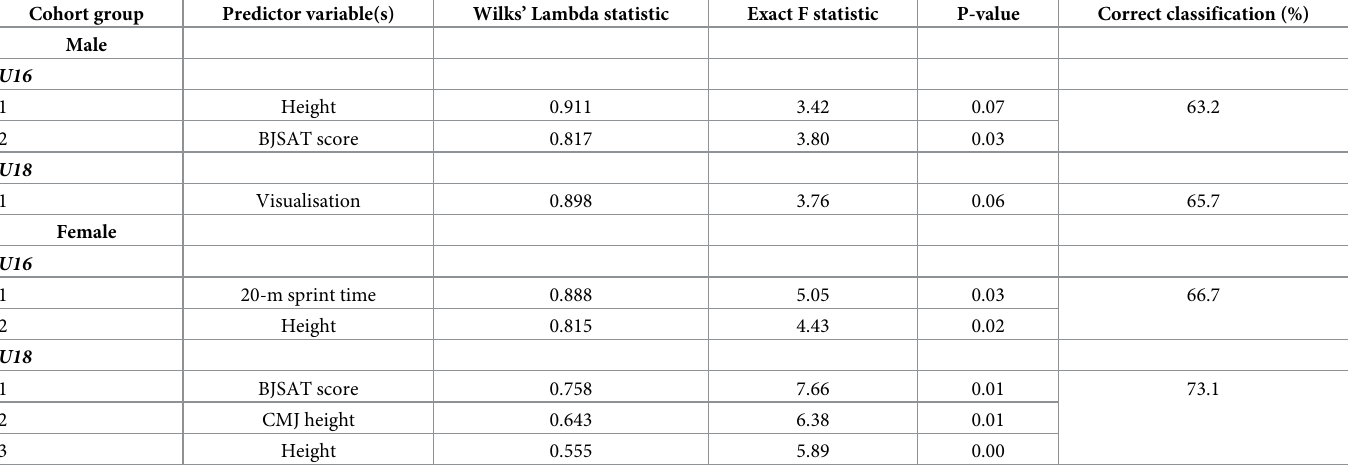
Table 3. Stepwise discriminant analyses to identify the strongest variables predicting selection into a talent pathway in adolescent basketball athletes according to sex and age group. Cohort